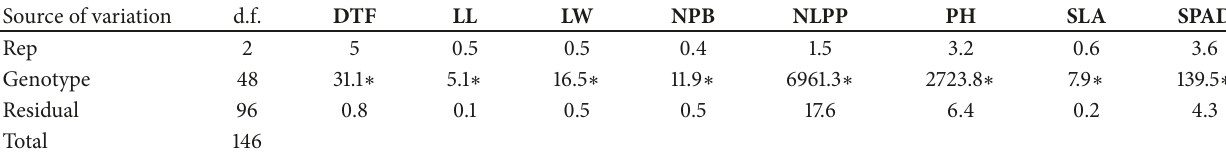
Residual (c) Analyses of variance showing the mean squares for the agronomic traits in Cleome gynandra for the combined seasons. Source of variation